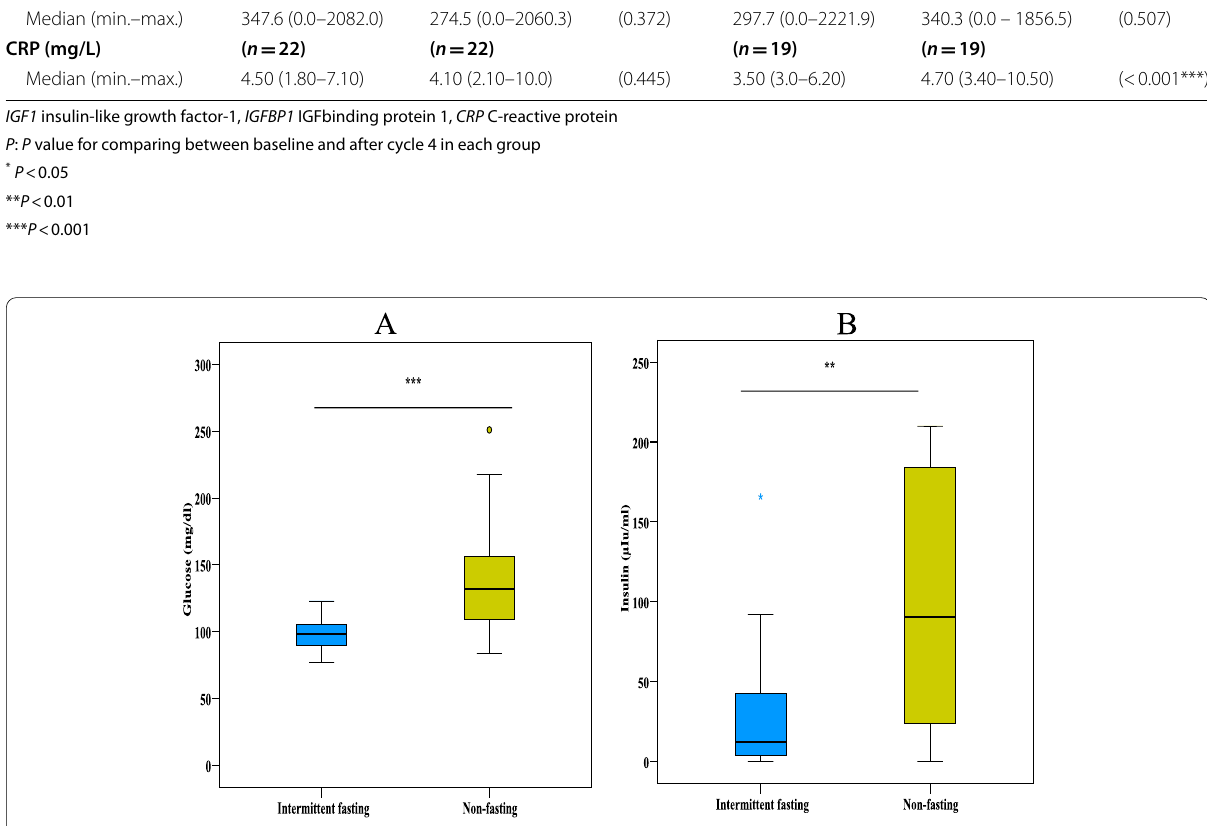
Fig. 2 A comparison between the two examined groups concerning glucose (mg/dl) and insulin (µIU/ml) levels after cycle 4. A shows a significant increase in median glucose levels in the non‑fasting (NF) group compared to the intermittent fasting (IF) group after cycle 4. B shows a significant increase in median insulin levels in the NF group compared to the IF group after cycle 4. Information is displayed by the box‑and‑whisker plot. ** P < 0.01 and *** P < 0.001 vs. the other